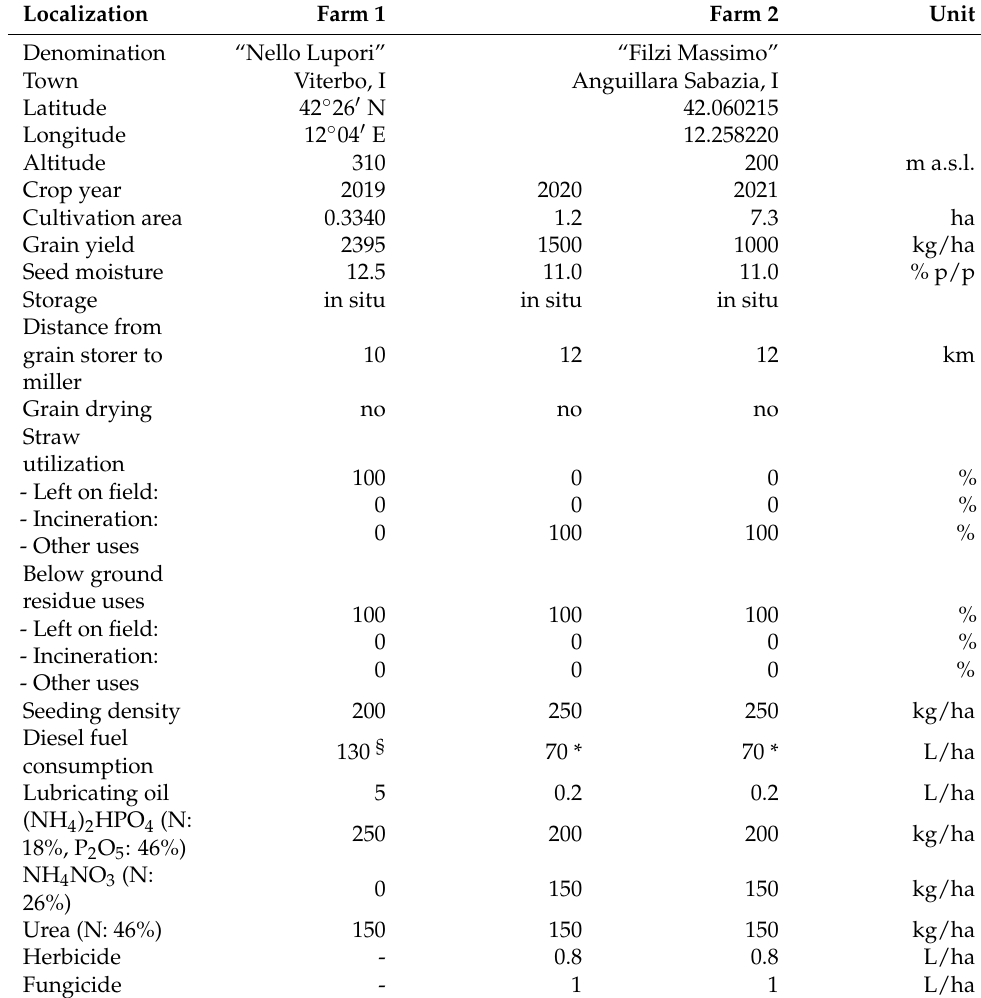
Table 1. Cultural conditions used to grow high-amylose bread wheat in two agricultural farms.